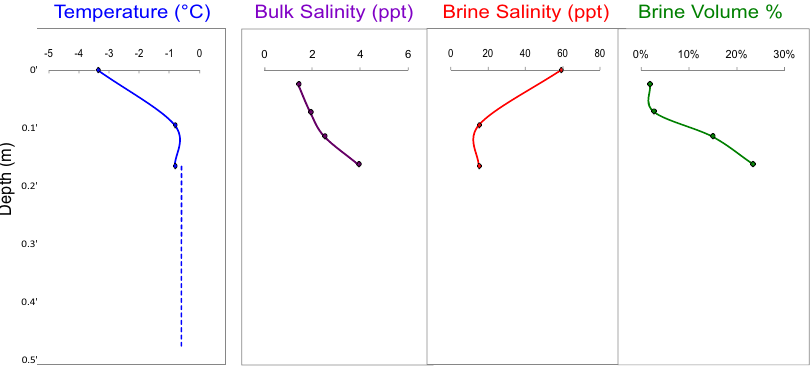
Figure 1. Environmental variables for representative dates during the 2009 (cid:177) 2010 winter season at Miquelon Lake, Alberta, Canada. Solid lines are for measured parameters in ice; dashed lines are for measured parameters in the underlying water. Ice temperature and bulk salinity were measured directly. Brine salinity and brine volume were calculated from measured ice temperature and bulk ice salinity according to Cox and Weeks